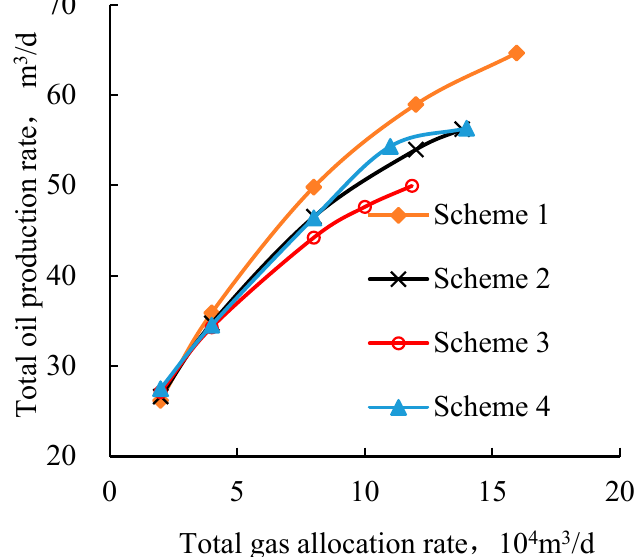
Figure 5. Block GLEPCs of various schemes with the maximum daily cash income NPV.